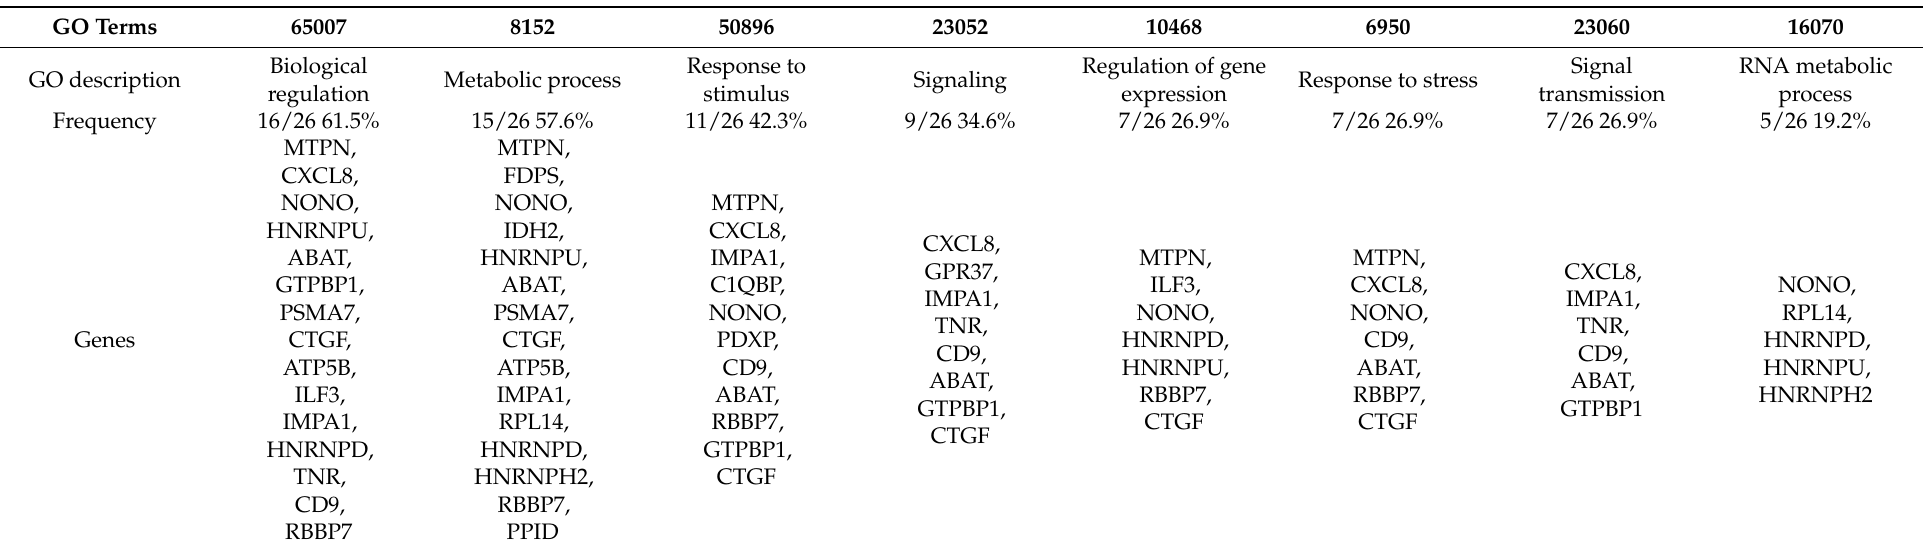
Table 4. Gene Ontology analysis. Categorized by biological